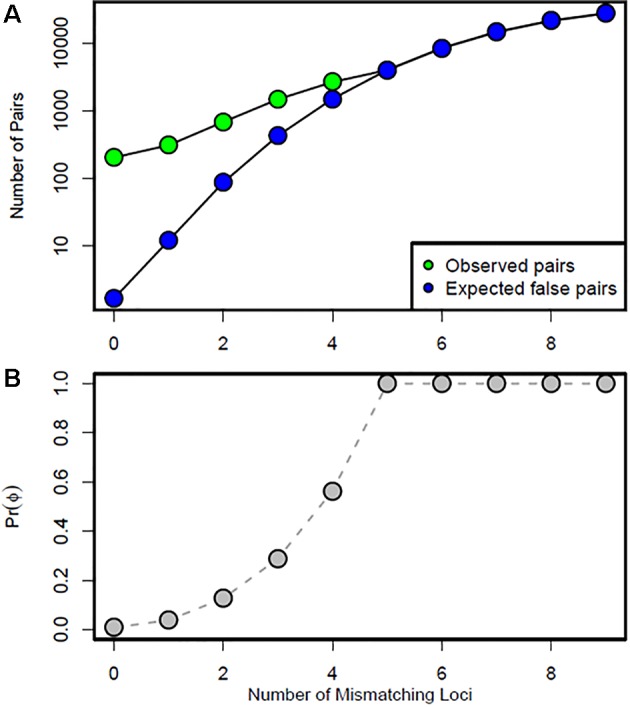
Data simulation results: (A) number of observed putative (green points) and expected false (blue points) parent–offspring pairs in the test datasets, and (B) Bayesian prior probability Pr(Phi) according to the number of mismatching loci. Any pair that mismatched at one locus would have a 0.03547 probability of occurring by chance.